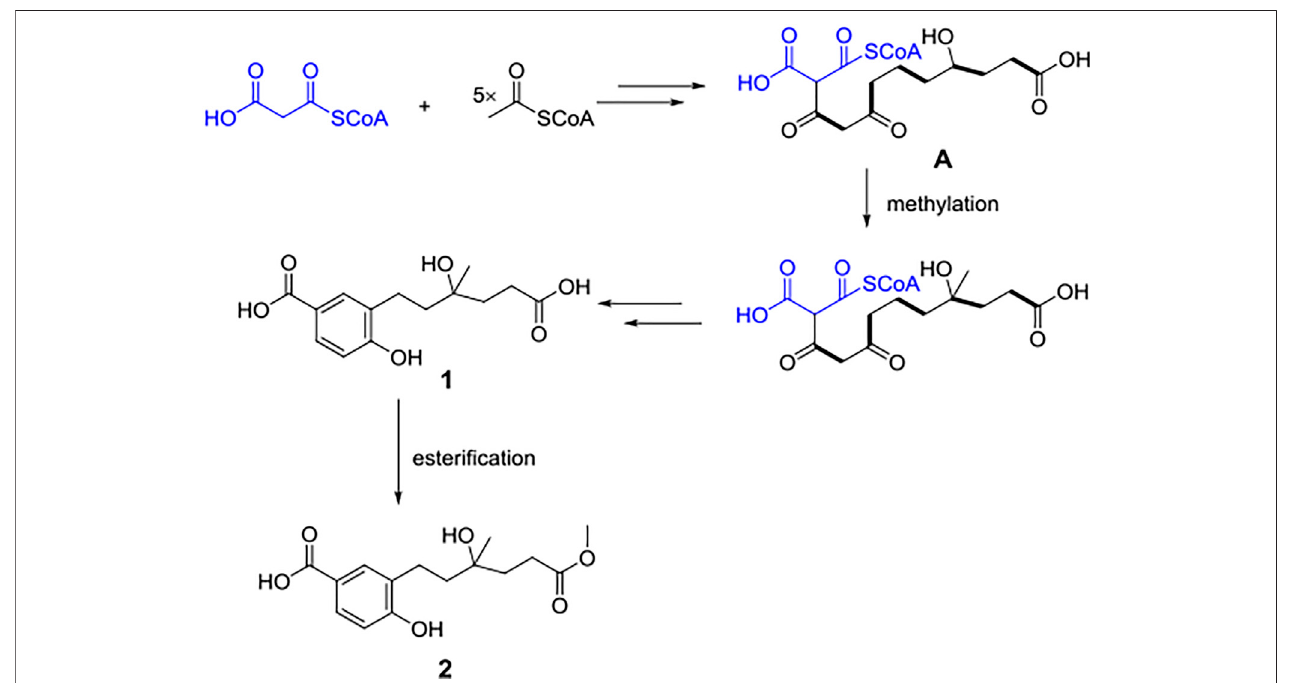
FIGURE 4 | Hypothetical biogenetic pathway of compounds 1 and 2